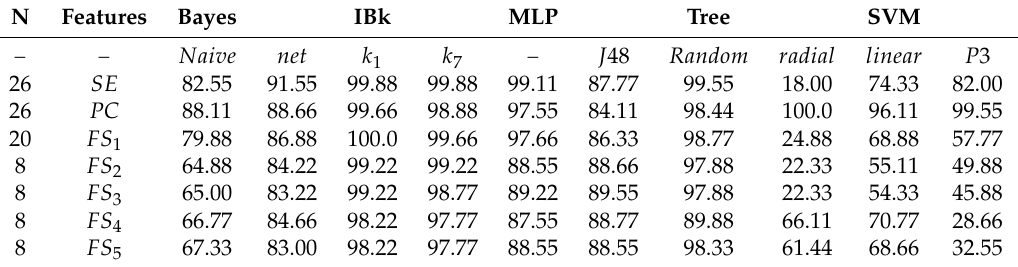
Table 6. Classification performances using different feature vectors after feature selection: SE = [ Ch 1 Arb(1,2,5,9,10), ch 1 k(1,2,3,4,9), Ch 1 WL, Ch 1 SSC, Ch 1 ZC, Ch 1 MYOP, Ch 2